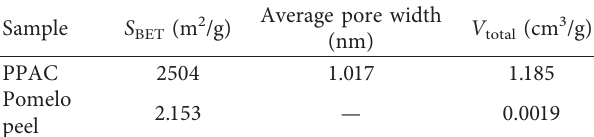
Figure 6: XRD patterns of PPAC. Table 4: BET analysis results of